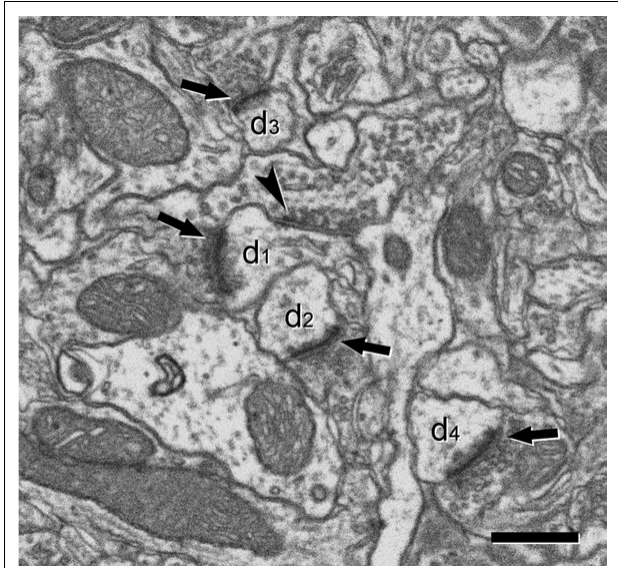
FIGURE 3 | Ultrastructural appearance of asymmetric and symmetric synapses. Four asymmetric synapses (arrows) and one symmetric synapse (arrowhead) can be identifi ed on four dendritic spines (d to d ). Asymmetric 1 4 synapses show a thick post-synaptic density. The symmetric synapse has a thin post-synaptic density, very similar to the pre-synaptic density, and it is located on the neck of a dendritic spine (d ). Scale bar, 500 nm. 1 much lower resolutions (up to 8 nm/pixel) although they were blurred and with insuffi cient detail to recognize smaller structures such as synaptic